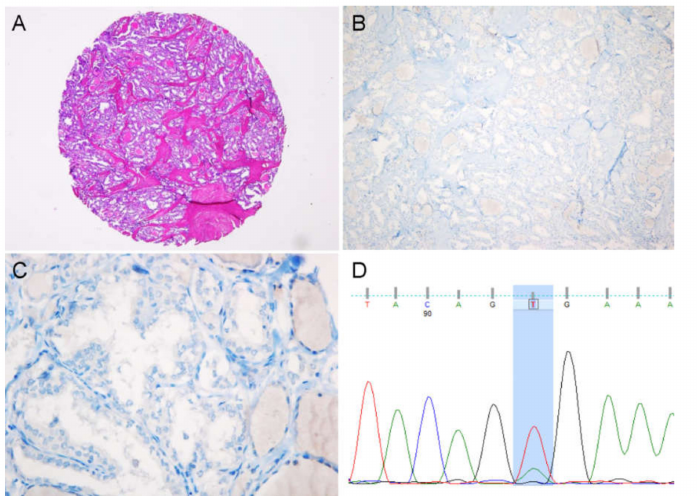
Figure 4. False negative VE1 immunostaining. A predominantly follicular-patterned PTC ( A ) was negative for VE1 immunostaining ( B, C ), whereas Sanger sequencing revealed heterozygous BRAF V600E